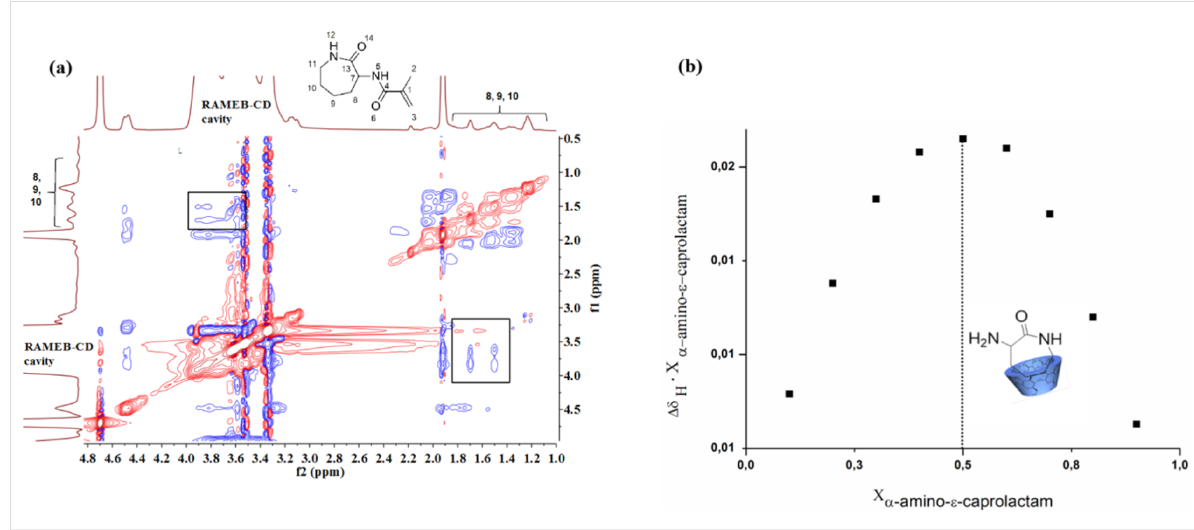
Figure 2: 2D NMR ROESY (300 MHz, D 2 O) spectrum of monomer 4 CD (a), Job plot of 2 with RAMEB-CD (b).